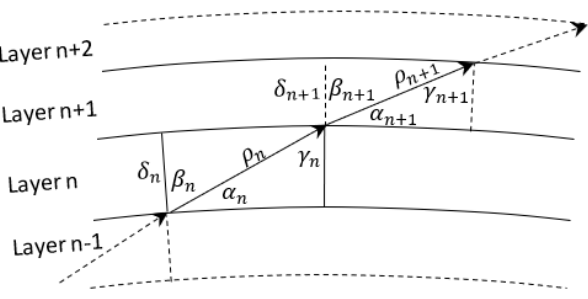
Figure 7. Layered air model for atmospheric attenuation calculation [13].